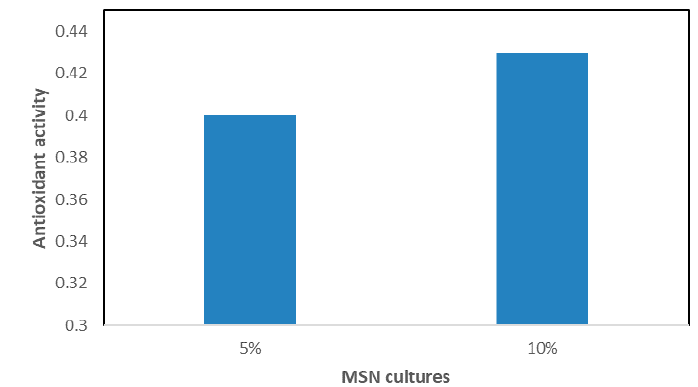
Figure 4. Antioxidant activity (DPPH) of C. sorokiniana cultures prepared with MSN at different concentrations. Microalgae cultures were incubated with media obtained by extraction of wine residues (MSN) at 5 and 10% w / v . Both cultures were inoculated with 25 µg Chl/mL, with 100 µmol of photons/m 2 /s of white light, incubated at a temperature of 25 °C and were fluidized with air enriched in CO 2 (5% v / v ). Antioxidant activity expressed as (µmol DPPH min − 1 mL − 1 10 2 ), was calculated at the end of the experiment (192 h) as indicated in Materials and Methods